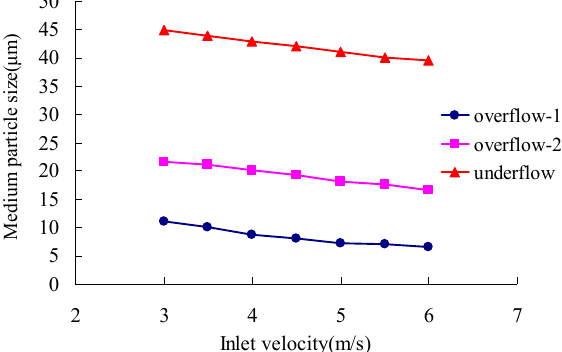
Figure 13. Variation of the medium particle size of the product.